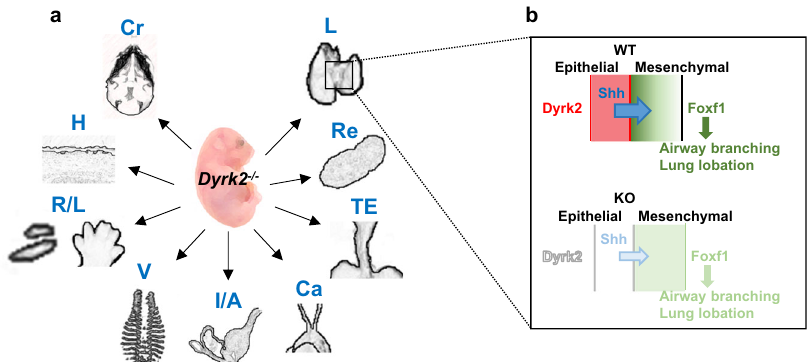
Fig. 6 A schematic diagram of Dyrk2 loss in mice. a Dyrk2 -de fi cient mouse mimics congenital malformation phenotypes. Cr craniofacial malformations, H hair follicle anomalies, R/L radial/limb anomalies, V vertebral defects, I/A intestinal/anorectal malformations, Ca cardiac defects, TE tracheoesophageal malformations, Re renal malformations, L lung defects. b Epithelial-expressed Dyrk2 is required to form a subepithelial-to-distal expression gradient of Foxf1 by regulating Shh signaling. Loss of Dyrk2 leads to the reduction of Foxf1 expression in the subepithelial area via the Shh